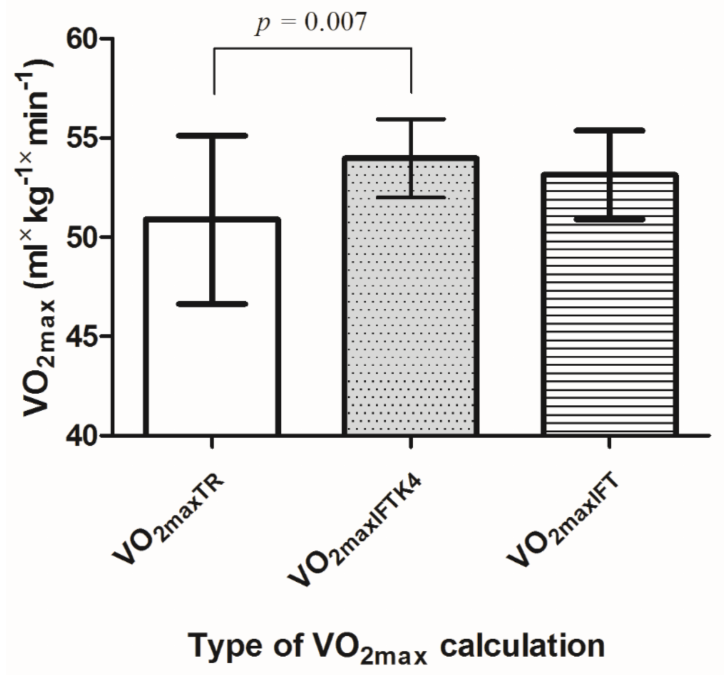
Figure 1. Comparison of VO 2max values obtained by the continuous treadmill test (VO 2maxTR ), 30-15 IFT measured by a portable metabolic analyzer (VO 2maxIFTK4 ), and the 30-15 IFT proposed calcu- lation (VO 2maxIFT ).